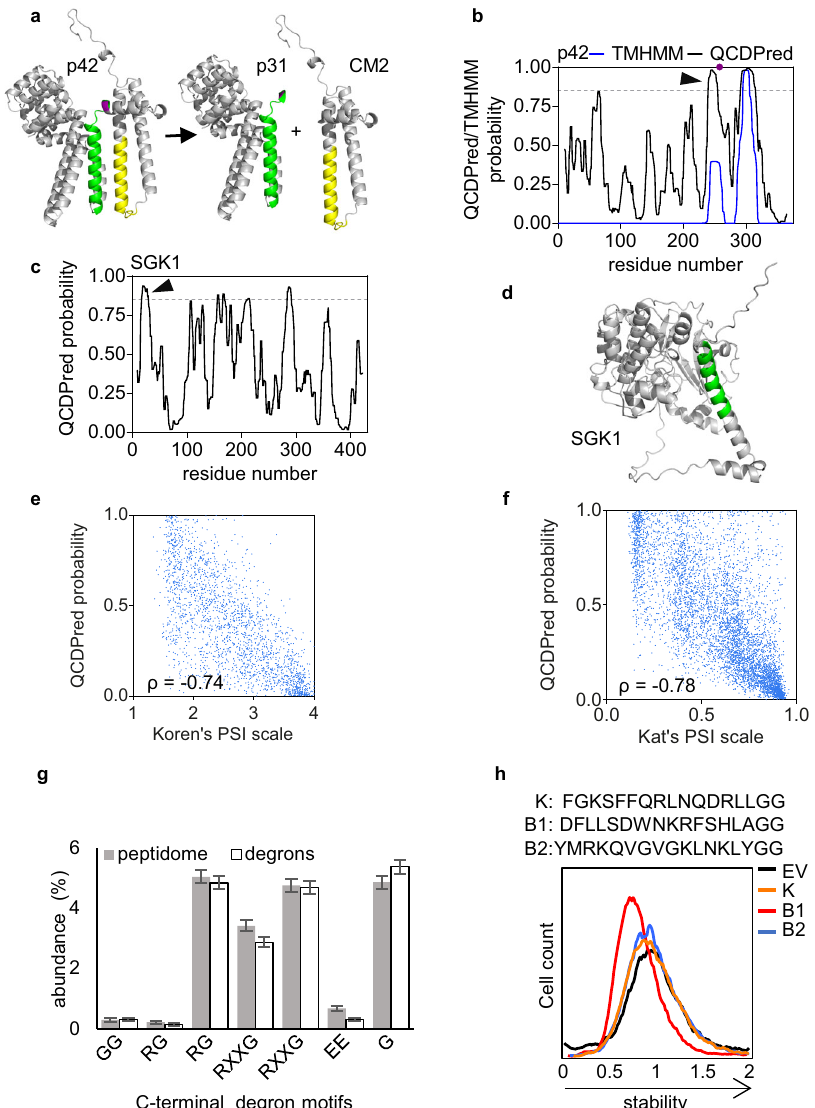
Fig. 6 | Degron projections in non-yeast organisms. a Assignment of QCDPred projected degrons into the in fl uenza C virus Polyprotein p42 trRosetta-predicted 3D structure (Template modeling score: 0.642). Shown are the schematics of p42 cleavageataninternalSPsite(markedinpurple)intop31andCM2. b QCDPredand TMHMM probabilities of p42 degrons. Arrowhead indicates the position of the postulated p31 degron. A degron cutoff probability is marked at P = 0.85 by a dashed gray line. c QCDPred-calculated degron probabilities within SGK1. Arrow- head indicates the position of the postulated SGK1 degron. A degron cutoff prob- ability is marked at P = 0.85 by a dashed gray line. d Assignment of a QCDPred- identi fi ed QCAP degron (colored green) into the AlphFold-predicted SGK1 struc- ture (#AF-O00141-F1). e Scatter plot comparing PSI values of 23-mer C-terminal peptidesofthehumanproteome 22 and averaged